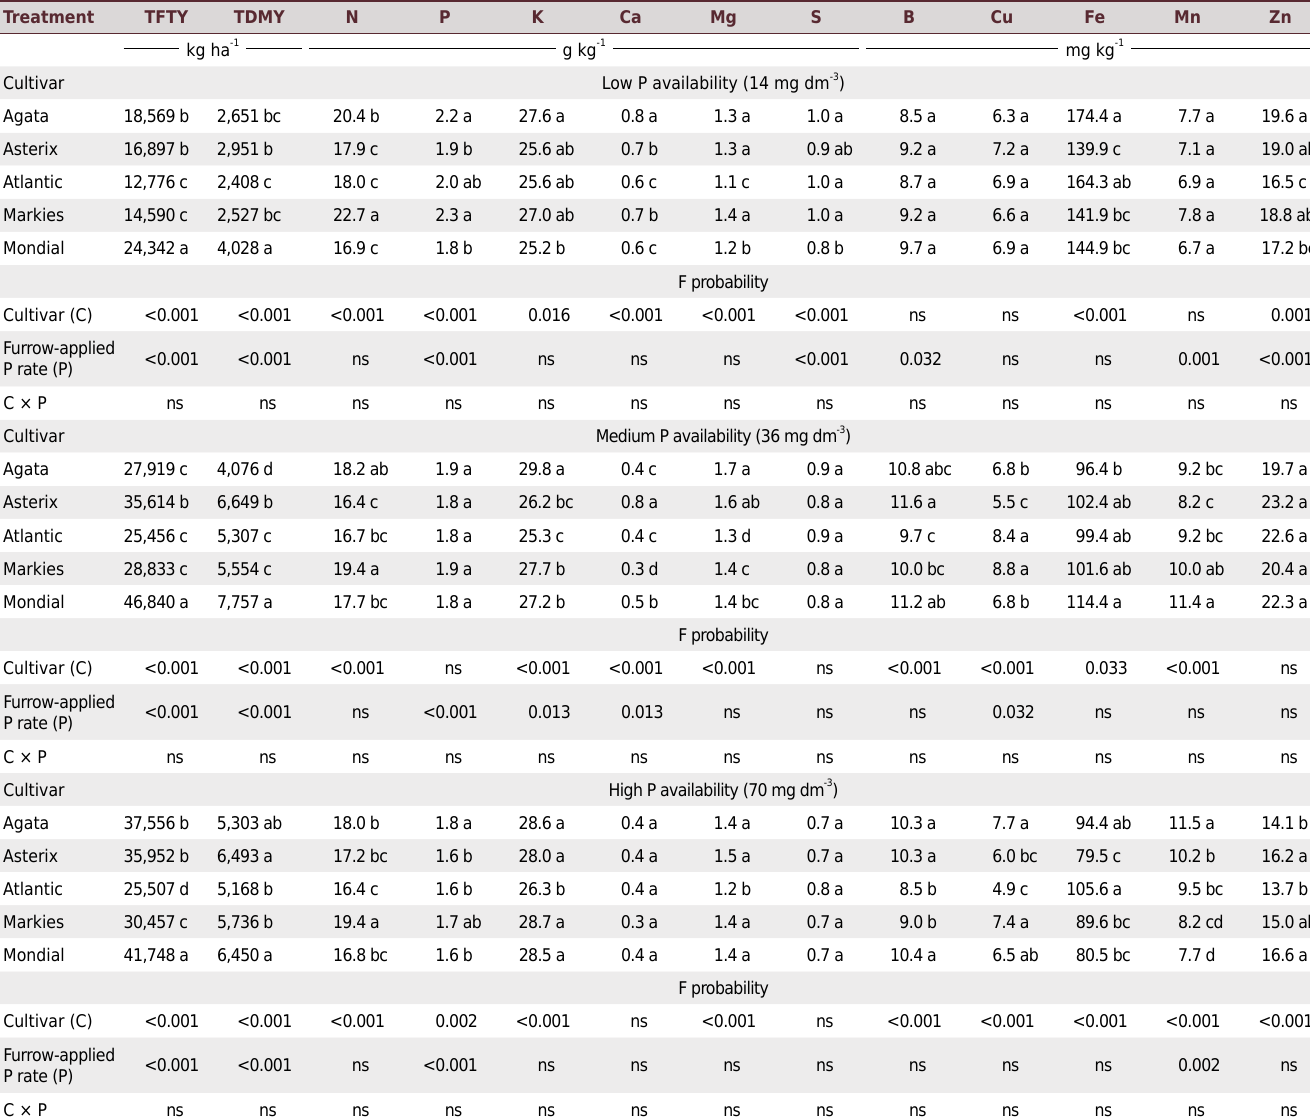
Table 4. Total fresh tuber yield (TFTY), tuber dry matter yield (TDMY), and nutrient (N, P, K, Ca, Mg, S, B, Cu, Fe, Mn, and Zn) concentrations in tubers of five potato cultivars as affected by rates of P applied in the planting furrow in soils with low, medium, and high P availability